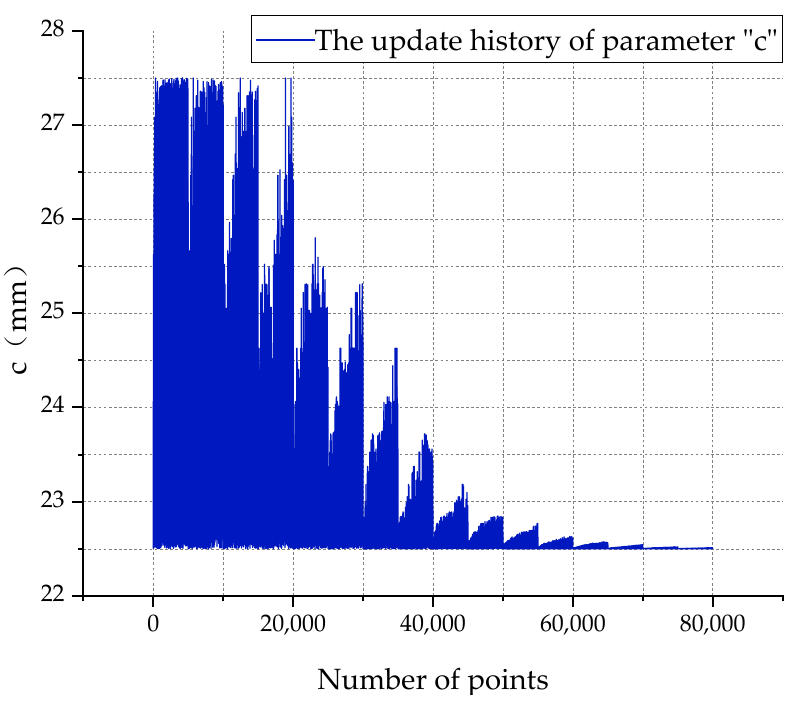
Figure 22. The iterative process of parameter “c”.